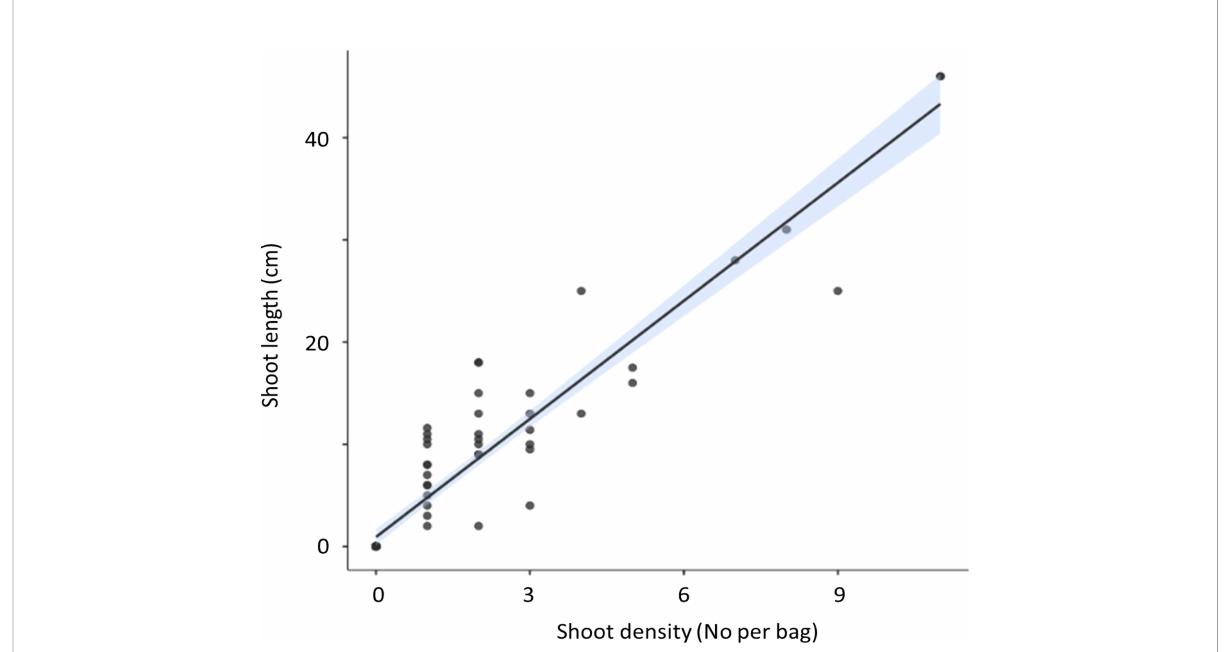
FIGURE 1 Correlation (± 95% CI) between seagrass shoot density and maximum shoot length of the seagrass Zostera marina (Z. marina) in hessian bags in Dale, Wales following experimental planting. Seagrass seeds were planted into hessian bags according to a factorial design of three treatments (sediment type, detritus addition, and nutrient